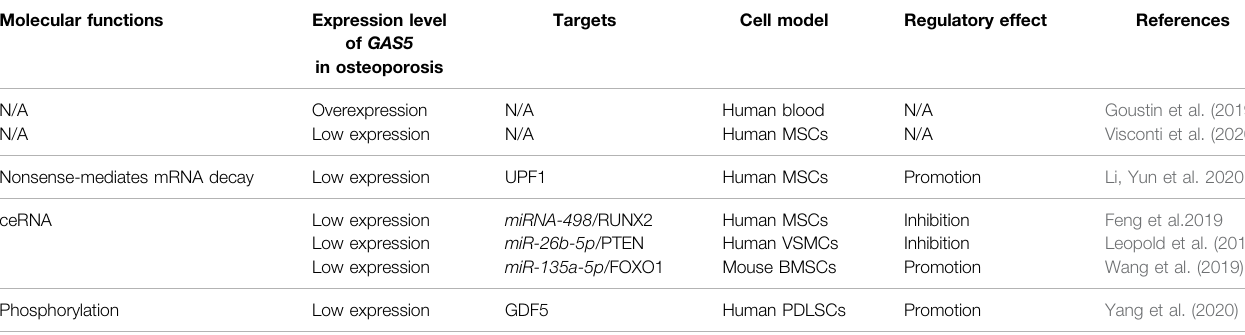
TABLE 2 | Regulation and expression level of GAS5 in different